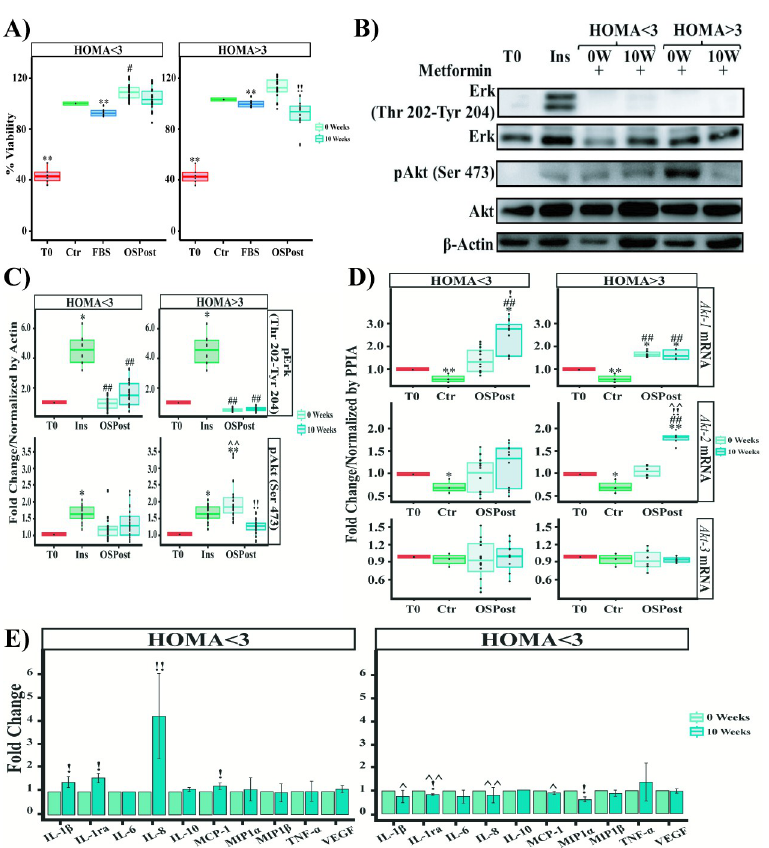
Fig 4. Effect of sera from Metformin-treated postmenopausal obese women on MCF-7 cells. A) Viability of MCF-7 cells exposed to OSPost serum without insulin resistance (HOMA < 3) and OSPost serum with insulin resistance (HOMA > 3). B) Western Blot of MCF-7 cells exposed to OSPost serum without insulin resistance (HOMA < 3) and OSPost serum with insulin resistance (HOMA > 3). C) Western Blot’s Densitometry of pErk (Thr 202-Tyr204) and pAkt (Ser 473) of MCF-7 divided by the presence of insulin resistance. D) Akt Isoforms expression levels on MCF-7 cells stimulated with OSPost at 0 and 10 weeks of Metformin treatment. E) Determination of serum molecule levels in postmenopausal obese women treated at 0 and 10 weeks of treatment with Metformin. Labels of Western Blot as described in Fig 2. Labels of RT-PCR as described in Fig 3. Western blot armed image. The plotted data correspond to three independent experiments (n = 3) for each serum evaluated. Comparison of means �� P < 0.005, � P < 0.05. �� Ctr or T0, ## 5% FBS or Ins, !! W0, ^^ respect HOMA < 3 vs HOMA > 3.